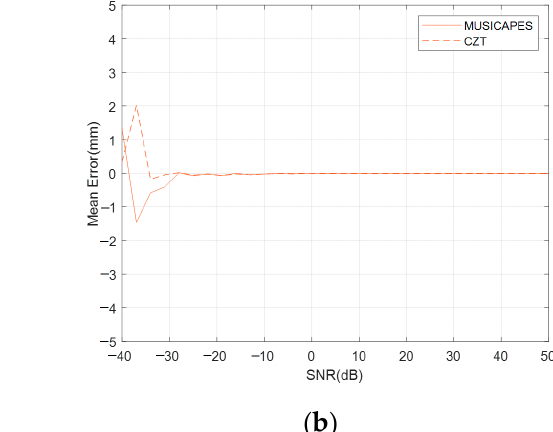
Figure 11. Mean error of displacement difference vs. SNR. ( a ) The mean error of ‘Target1’; ( b ) the mean error of ‘Target2’.